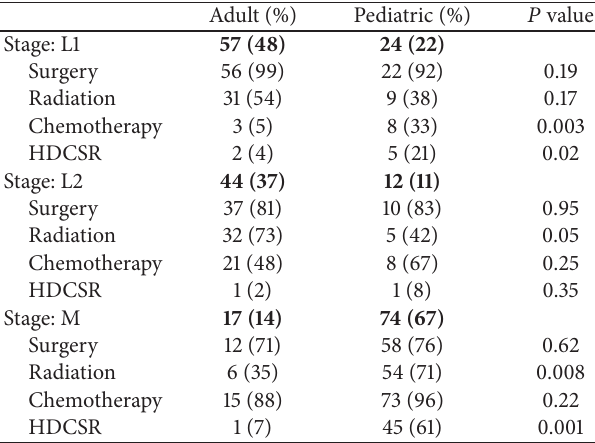
Table 1: Patient characteristics by stage of disease. Table 2: Treatment by stage of disease.